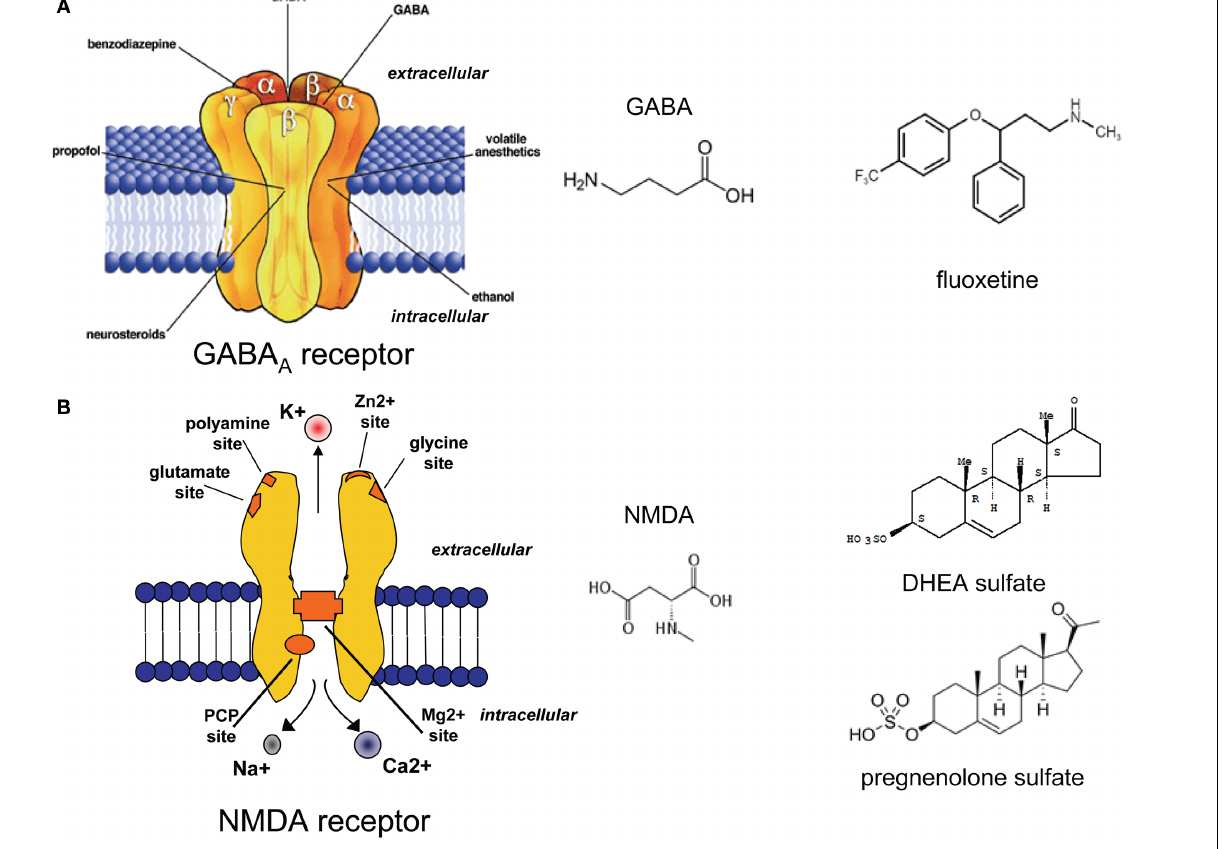
FIGURE 3 | Structure of the GABA A (A) and the NMDA (B) receptors. Molecular structure of GABA, and NMDA. DHEA sulphate and pregnenolone sulphate as positive NMDA receptor modulators, and the SERT inhibitor